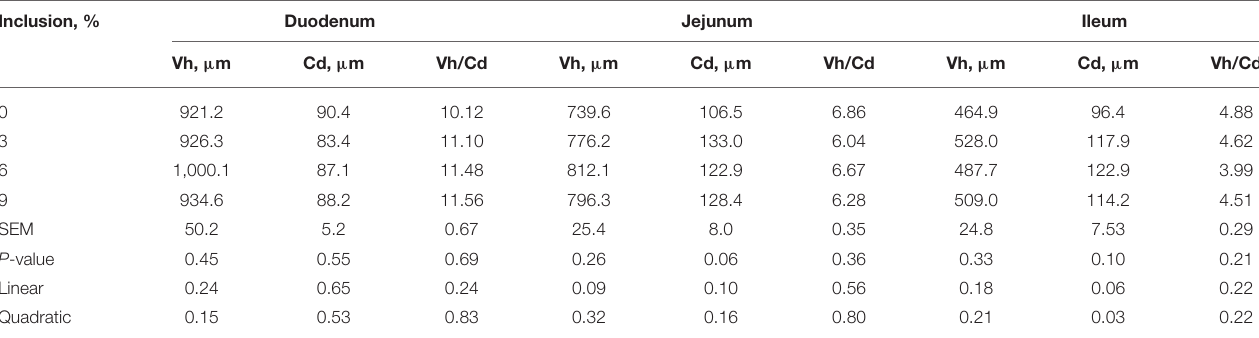
TABLE 4 | Effect of dietary low-inclusion levels of full-fatted black soldier fly larvae meal on the intestinal morphology of layer chickens at 42 days of age (each value represents the mean of six